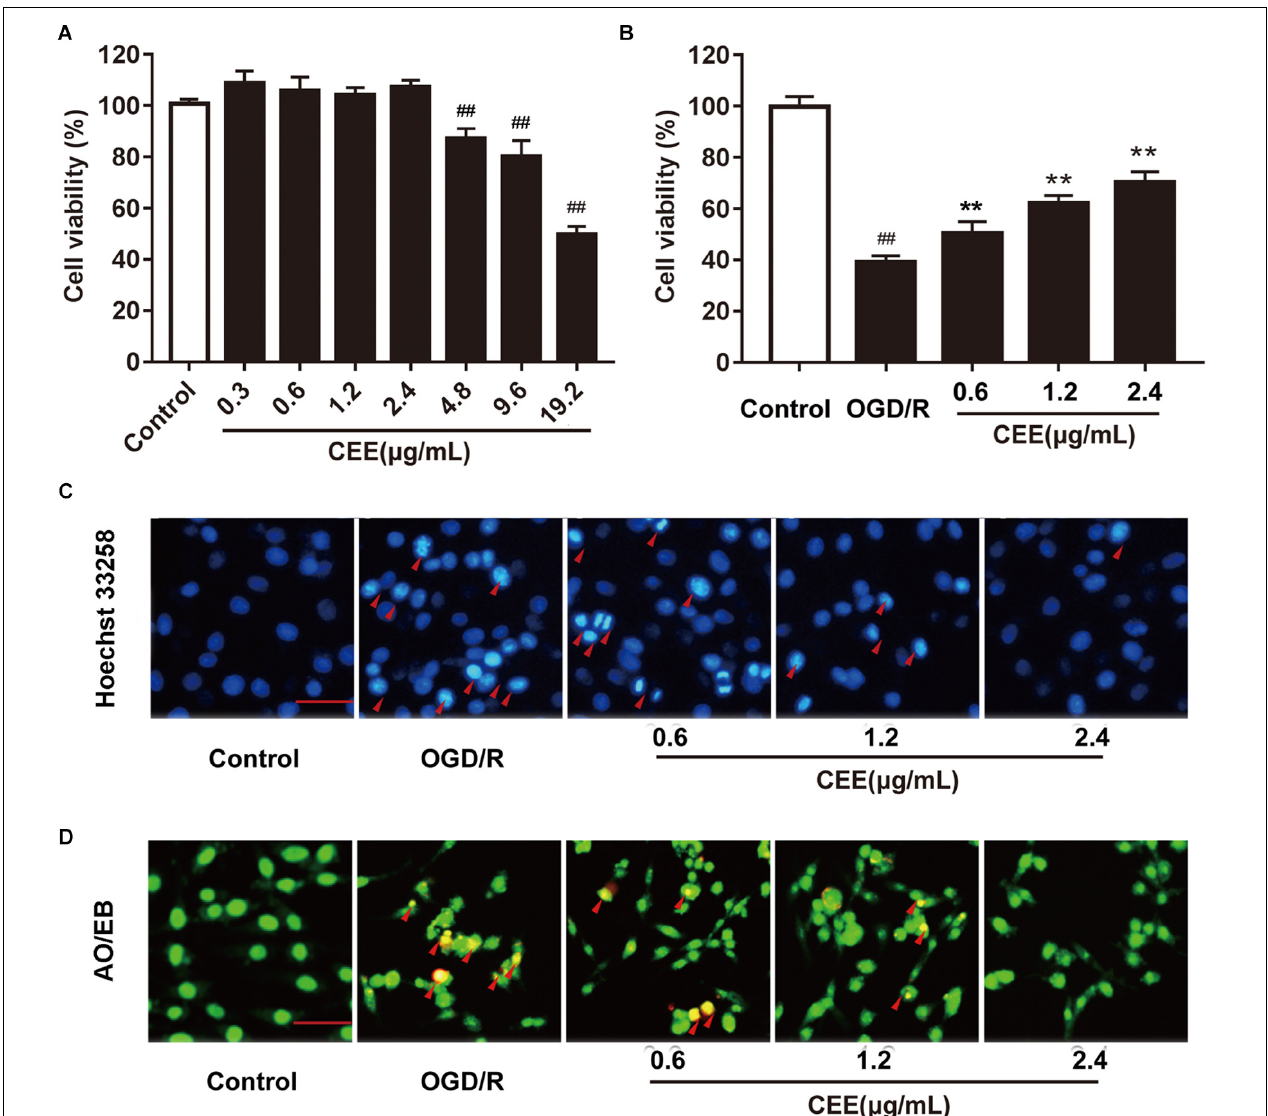
FIGURE 6 | Caesalpinia sappan ethanolic extract protects OGD/R-induced PC12 cell injury in vitro . (A) The effect of CEE on PC12 cell viability. (B) CEE increases PC12 cell viability following OGD/R-induced injury. (C) The anti-apoptosis effect of CEE on OGD/R-induced PC12 cells as evaluated through a Hoechst 33258 staining assay (scale bar: 20 µ m, n = 3). (D) AO/EB staining assay for the anti-apoptotic effect of CEE on OGD/R-induced PC12 cells (scale bar: 20 µ m, n = 3). Data are expressed as mean ± SD , n = 6. ## P < 0.01, # P < 0.05 vs. control group, ∗∗ P < 0.01, ∗ P < 0.05 vs. OGD/R